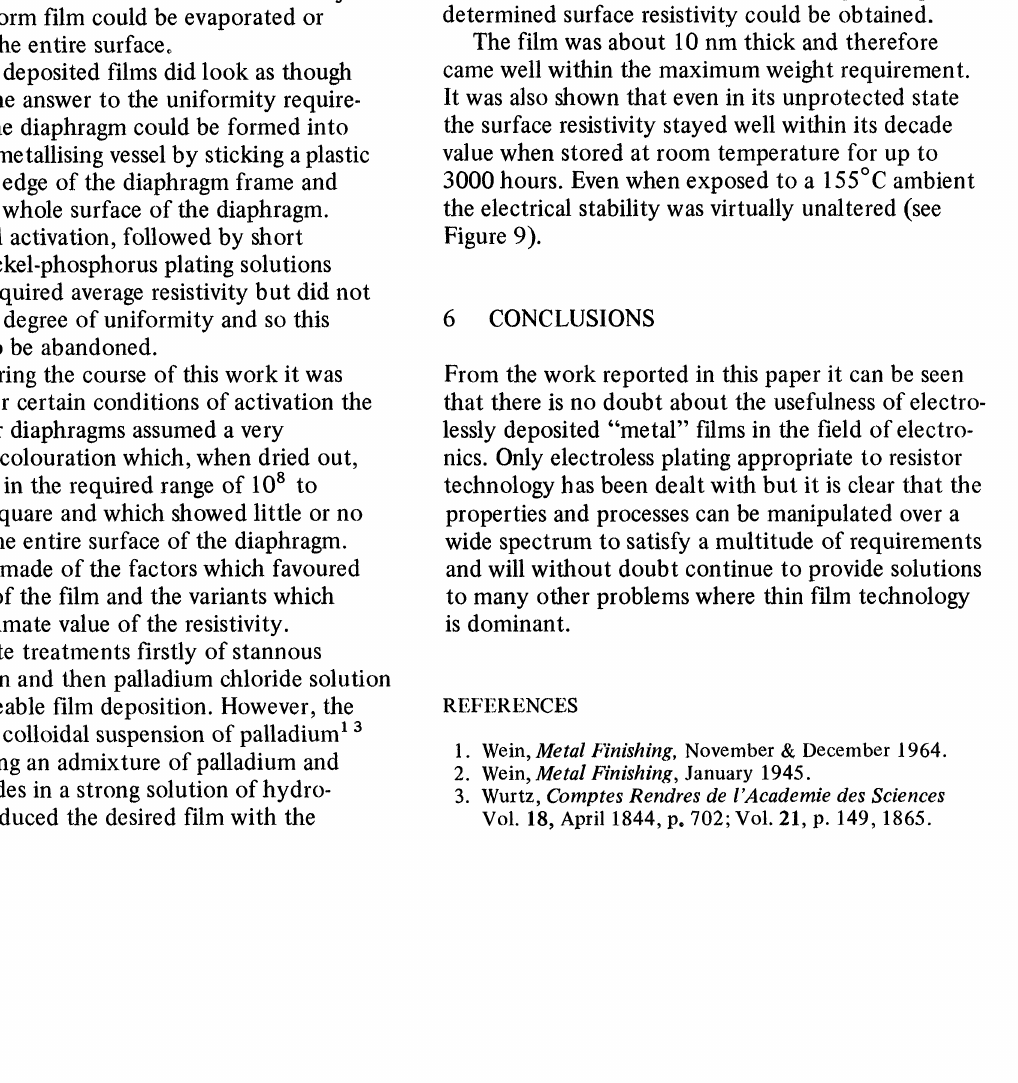
Change in resistance with time for a palladium- tin film on Mylar at room temperature and 155C. preferred resistivity. The film was shown to be a mixture of elemental palladium and stannic